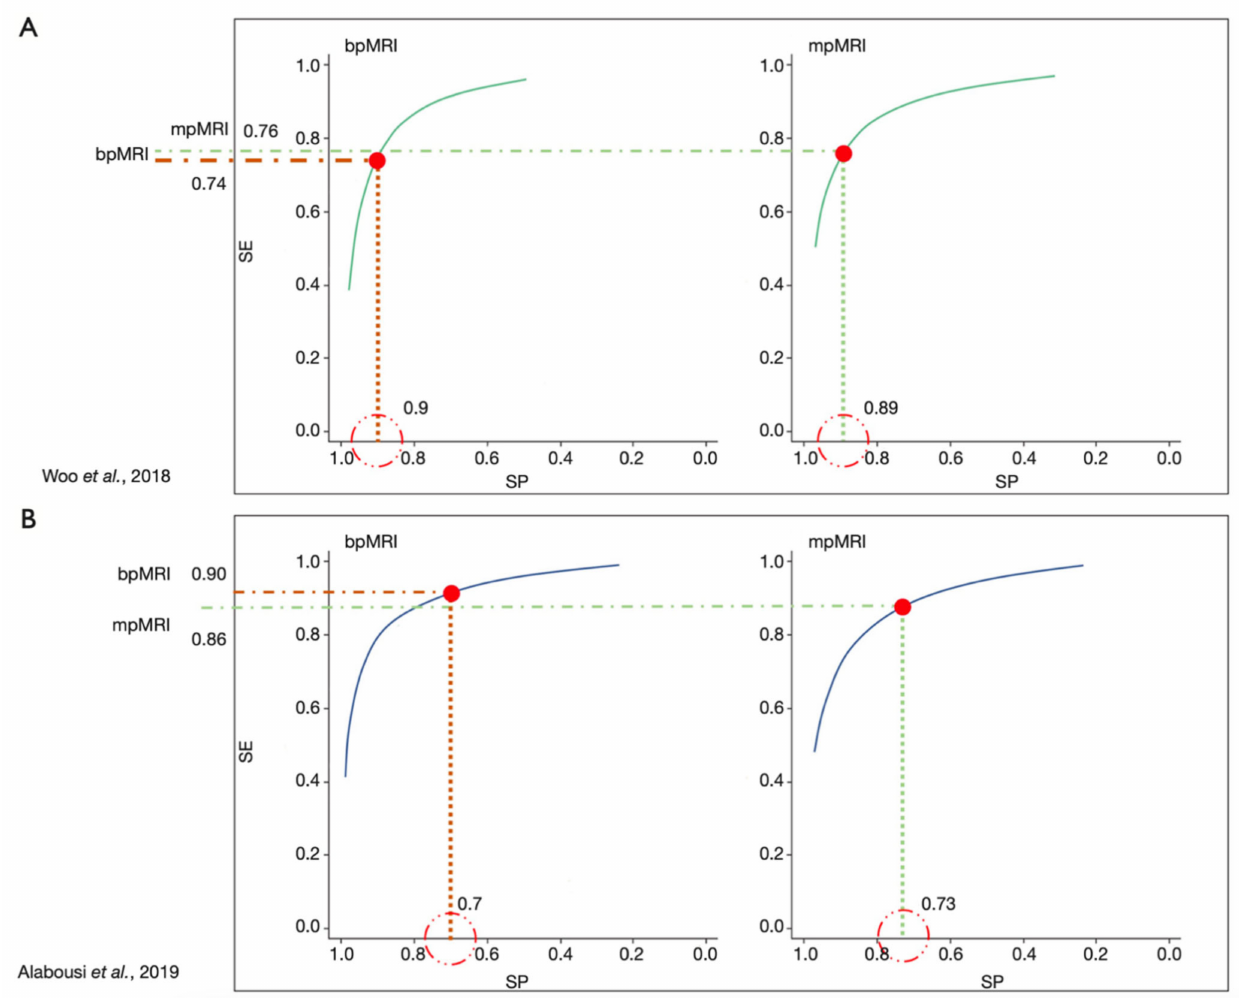
Figure 1. Overview of the performance of mpMRI and bpMRI based on data from Woo et al. [33] and Alabousi et al. [25] demonstrating the near equal performance of bpMRI to mpMRI (reprinted with permission from [17], Copyright 2020 Gland